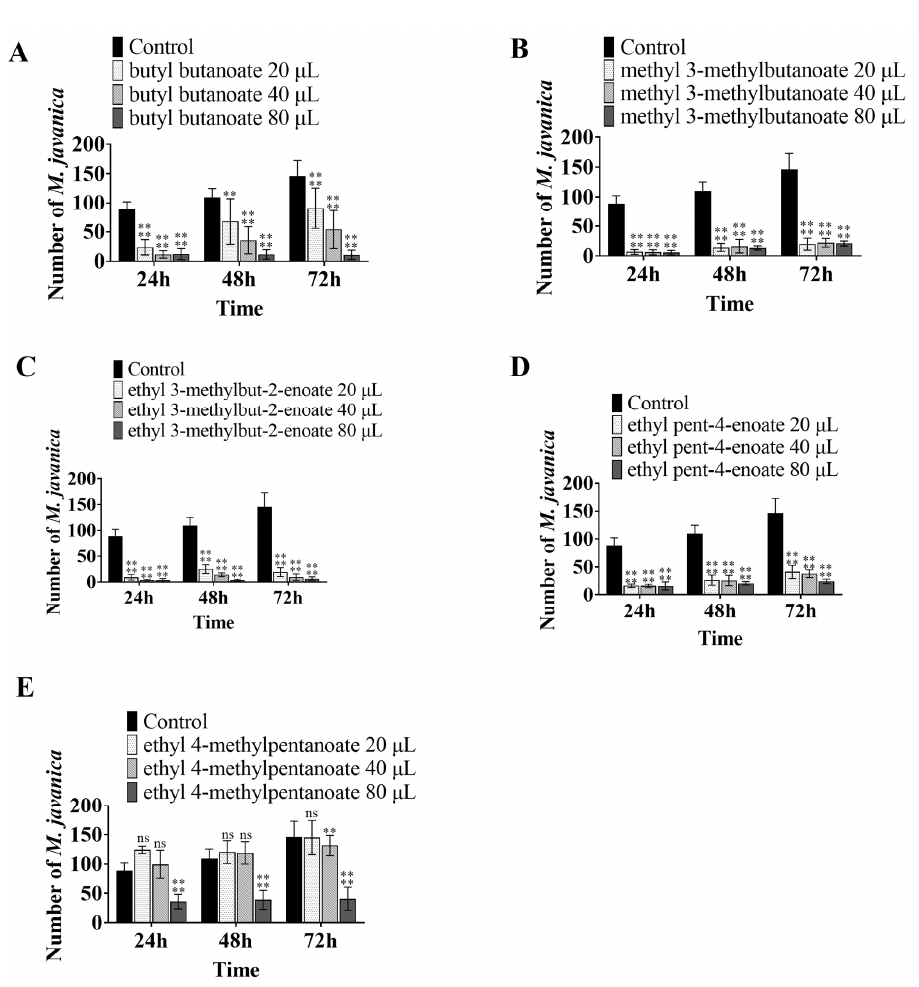
Figure 4. Inhibition of egg-hatching activity by VOCs. Bars represent the standard error of the means (n = 3). The asterisk above the columns indicates significant differences using ANOVA, **** mean p < 0.0001; ** mean p < 0.01: ( A ) the number of nematodes hatched in response to treatment with different doses of ( A ) butyl butanoate, ( B ) methyl 3-methylbutanoate, ( C ) ethyl 3-methylbut-2-enoate, ( D ) ethyl pent-4-enoate, and ( E ) ethyl 4-methylpentanoate. Root-knot nematodes are usually infected by bacteria and fungi, which also makes bacteria potential resources for controlling nematodes [42]. Several studies have indi- cated that bacteria and bacterial metabolites have great potential for use as biocontrol agents [43-45]. The current study was the first to show that B. diminuta had nematicidal